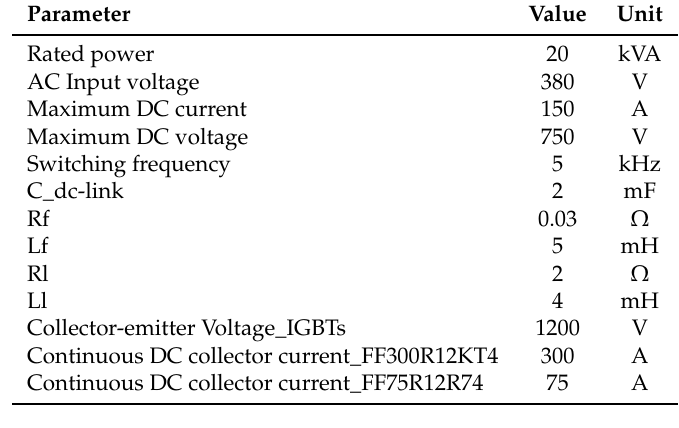
Table 4. Power stage main parameters.